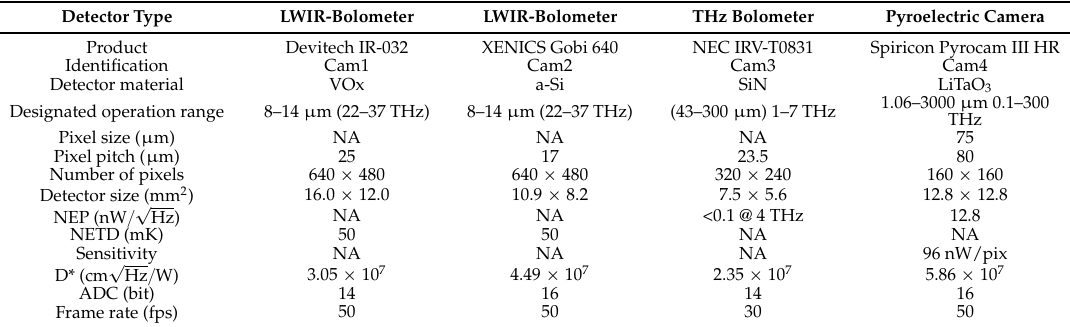
Table 1. Specifications according to data sheets of the terahertz (THz) detectors compared in this work. D* is calculated using Equations (3) and (4) as appropriate. Range figures in brackets are